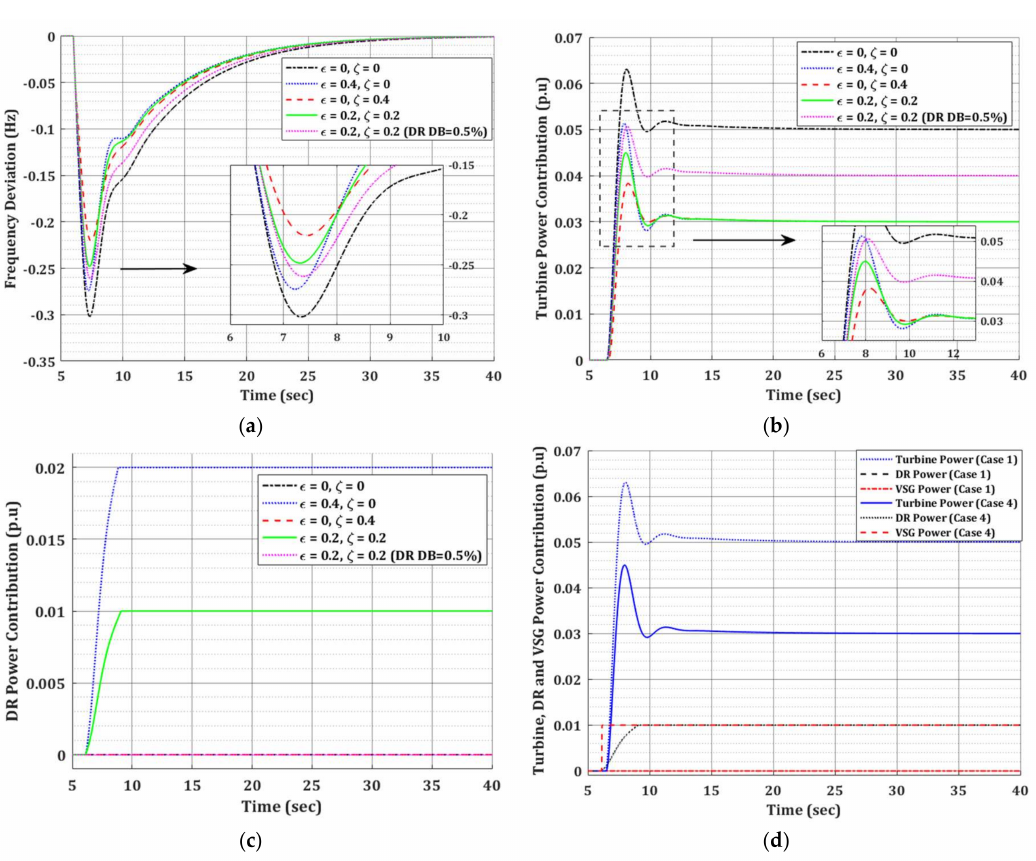
Figure 9. Effect of DR and VSG control on various system parameters under load disturbance: ( a ) system frequency response; ( b ) change in turbine power (p.u); ( c ) change in DR power (p.u); and ( d ) change in turbine, DR and VSG power (p.u) for selected